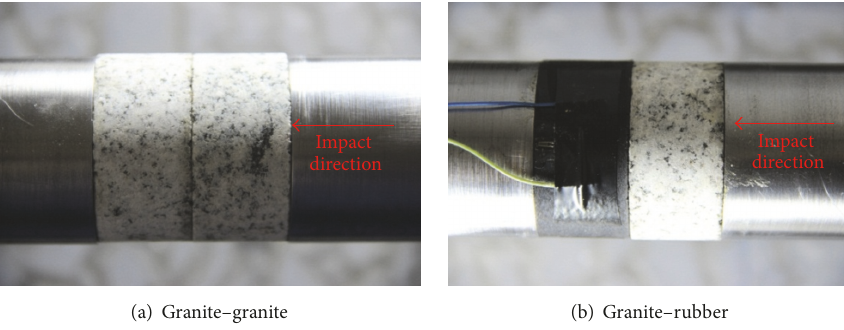
Figure 11: Composite specimens in SHPB